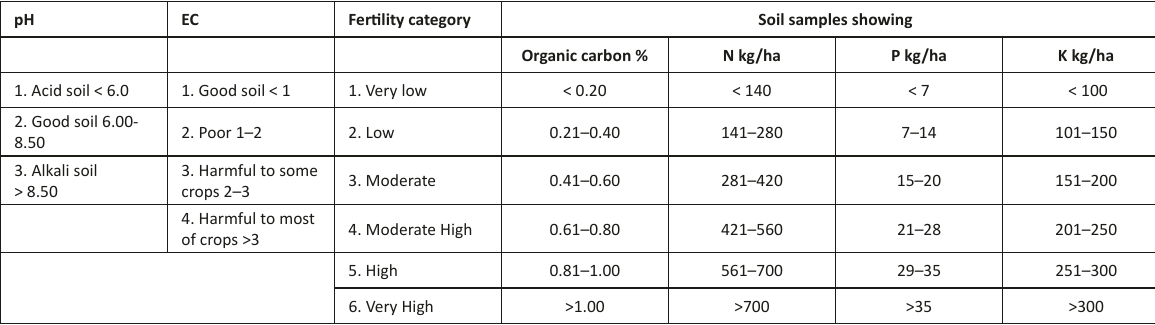
Table 2. Standard of soil parameters required for agriculture (Somawanshi et al. 1999). pH EC Fertility category Soil samples showing Organic carbon % N kg/ha P